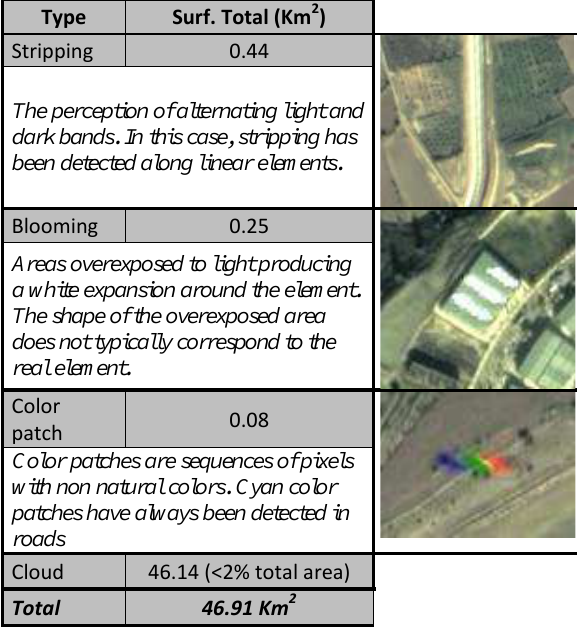
Table 5 . Artifact detection by type and extension